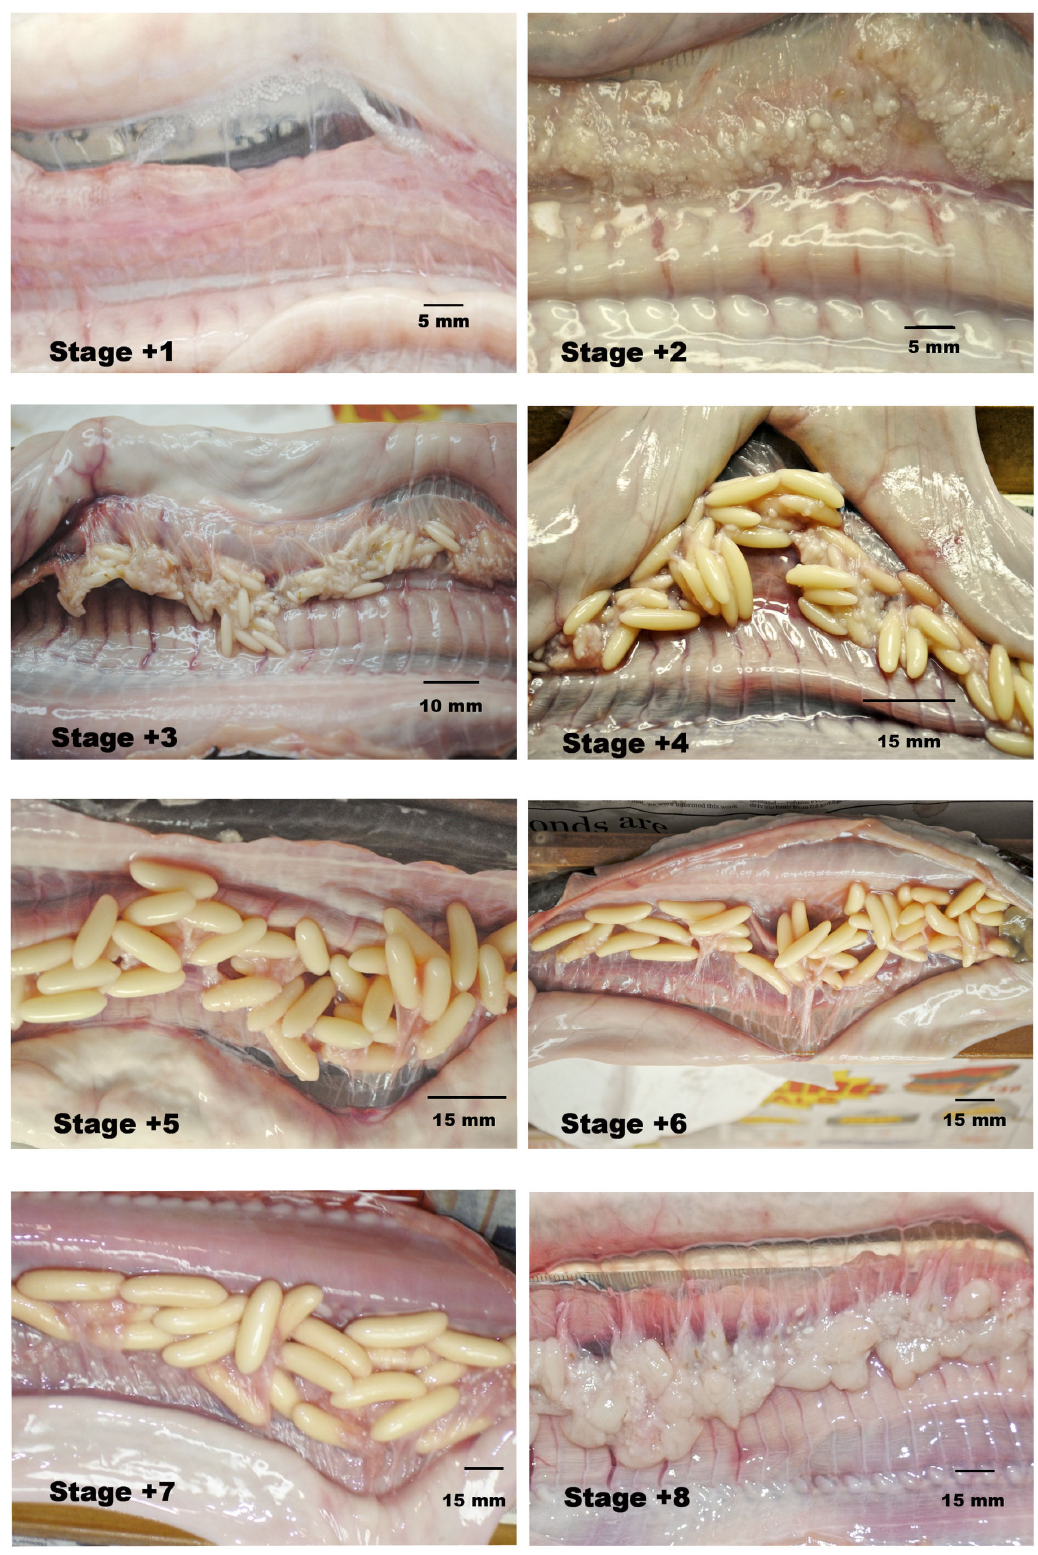
Figure 1. Stages of female sexual maturation (see Table 1).